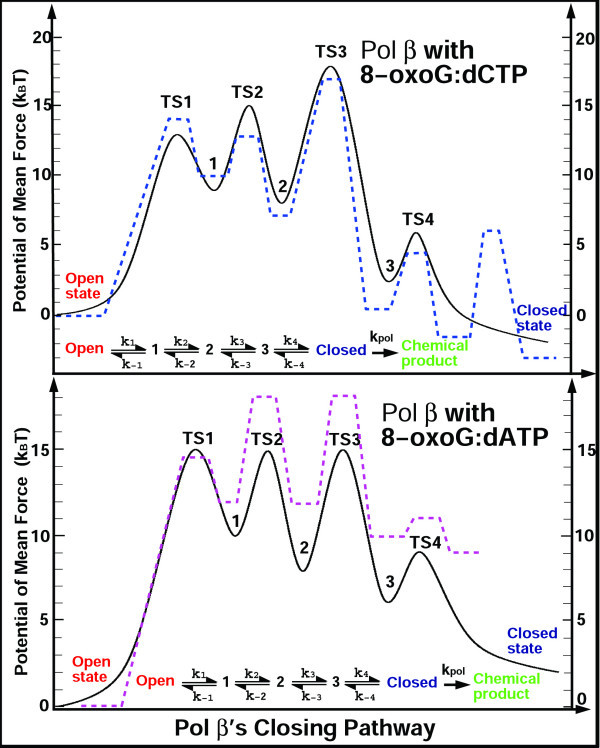
The resolved free energy profiles. The free energy profiles of the 8-oxoG:dCTP and 8-oxoG:dATP complexes during pol β's thumb closing. The superimposed dashed lines are approximate free energy profiles of nonlesioned G:C (blue) and G:A (magenta) systems [32], respectively.